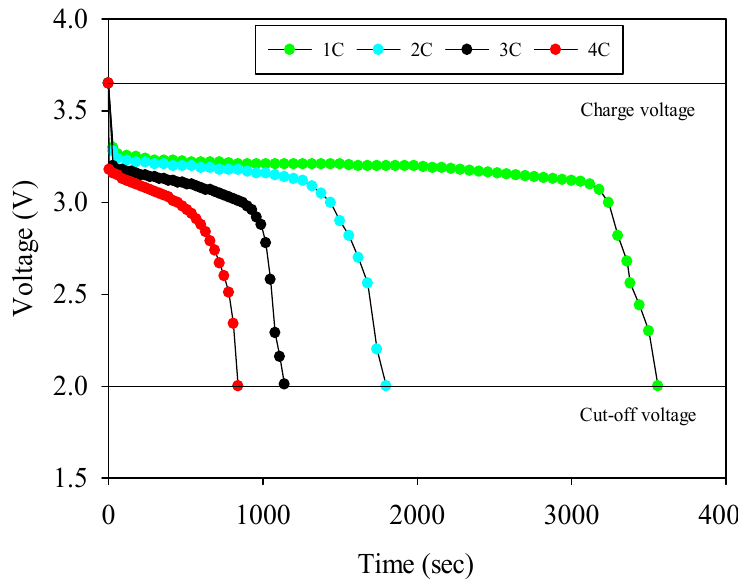
Figure 3. The variation of voltage with time for different discharge